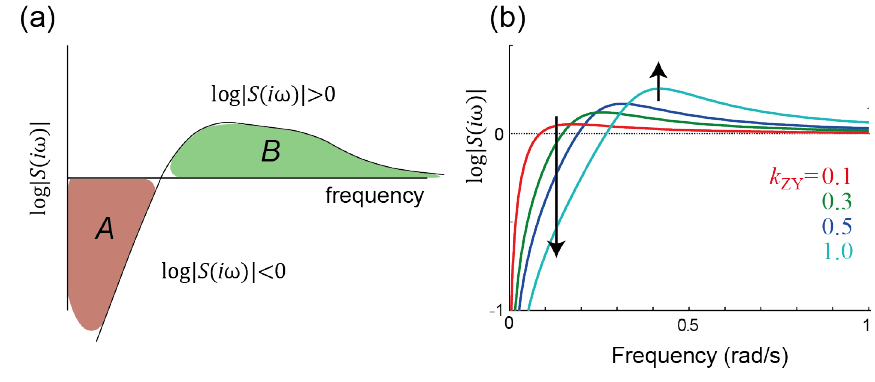
Figure 3. Frequency-domain constraints on sensitivity. (a) Waterbed effect and Bode’s integral. Bode’s integral (Equation 3) states that the total amount of sensitivity attenuation (the area where the gain of the sensitivity function is below one, shown in red and labeled A, must be matched (at least) by the total amount of sensitivity amplification (the green area, marked B). Thus, in the same way that pushing down on one part of a waterbed makes other parts of the bed rise, decreasing the sensitivity in one range of frequencies forces it to increase at other frequencies; (b) Illustration of the waterbed effect on the system of Figure 1. Note that, in the time domain, the increase in amplification at higher frequencies shows up as oscillatory behavior; see Figure